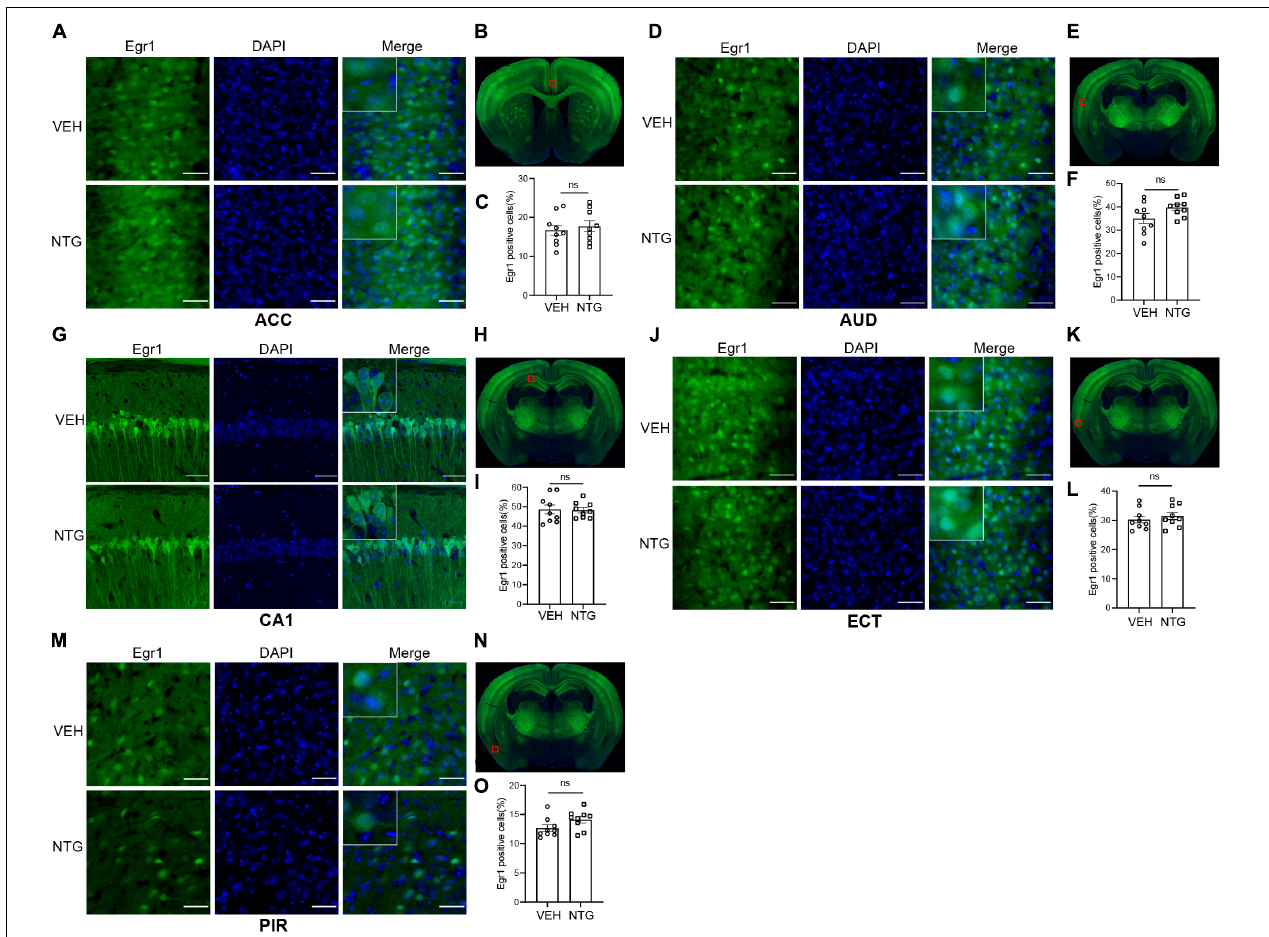
FIGURE 3 | Egr1 expression in ACC, AUD, CA1, ECT and PIR. No changes of Egr1 reactivity were observed in ACC (A,C) , AUD (D,F) , CA1 (G,I) , ECT (J,L) and PIR (M,O) of CM group compared with vehicle group. (B,E,H,K,N) Schematic representations of the analyzed areas. Student’s t -test. n = 3/group. Scale bars = 50 µ m. Egr1, early growth response protein 1; ACC, anterior cingulate area; AUD, auditory areas; ECT, ectorhinal area; PIR,